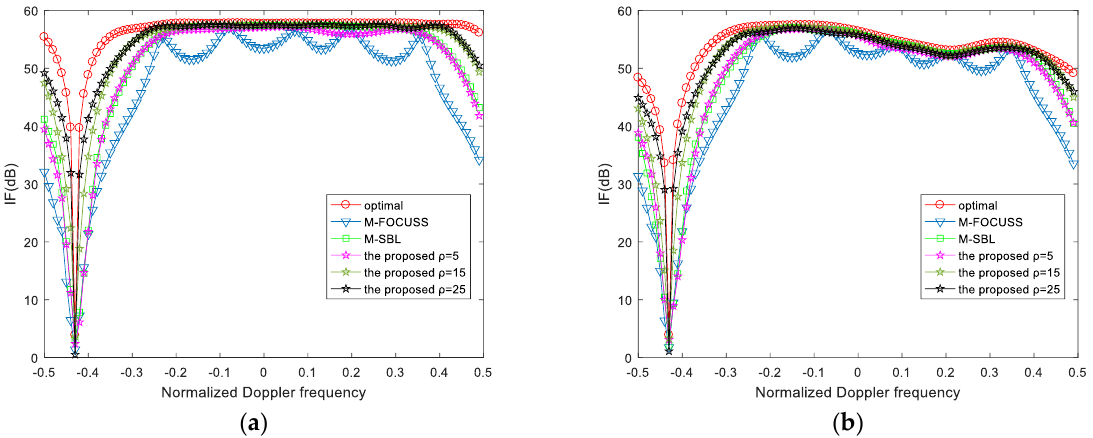
Figure 7. IF versus normalized Doppler frequency for a forward-looking radar. ( a ) Ideal case; ( b ) non-ideal case with array errors.